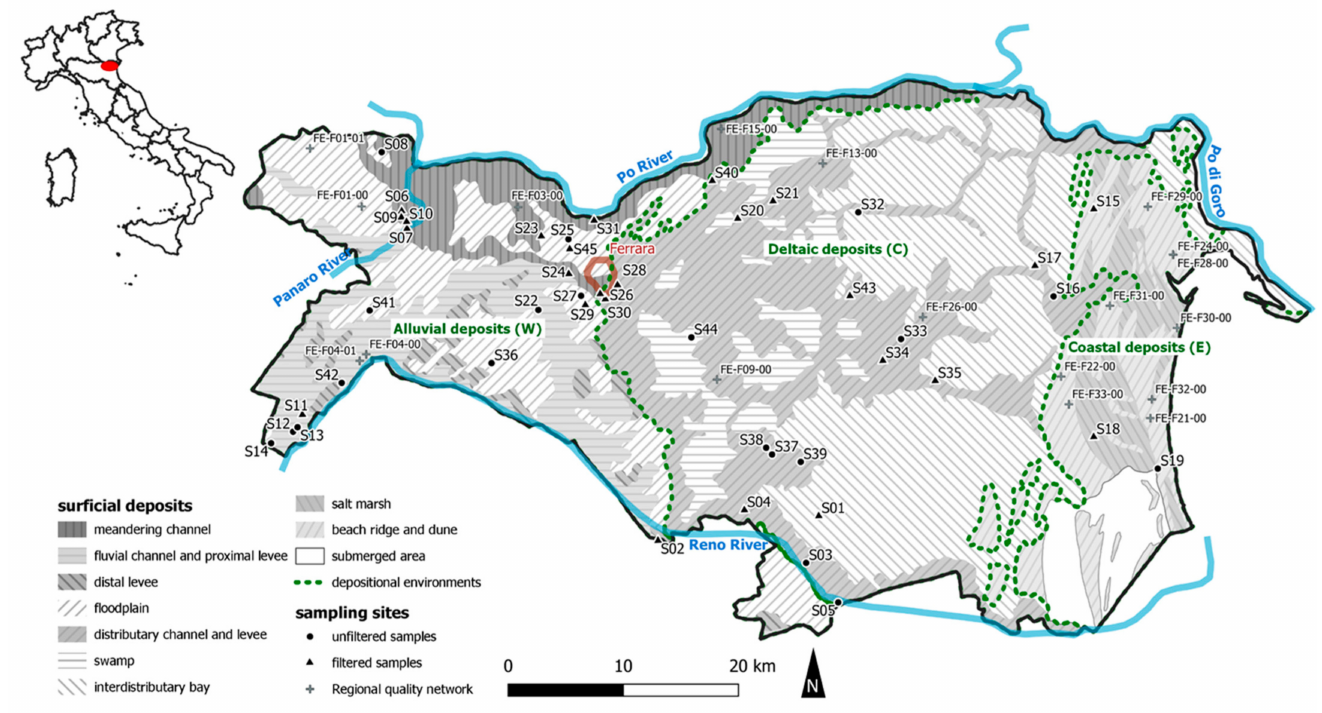
Figure 1. Surficial deposits in the administrative province of Ferrara (modified from the Geological Map of the Emilia Romagna plain 1:250,000) and sampling sites. In particular, sites under remediation are labeled as S xx whereas the sampling points of the regional monitoring network are labeled as FE-F xx-xx